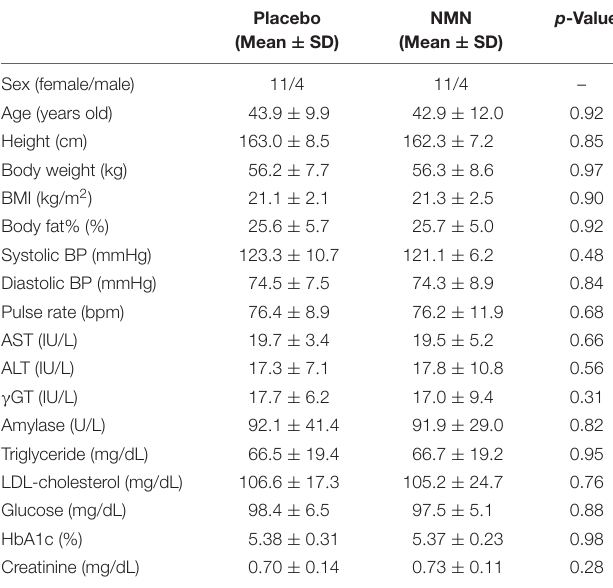
TABLE 1 | Background characteristics of the